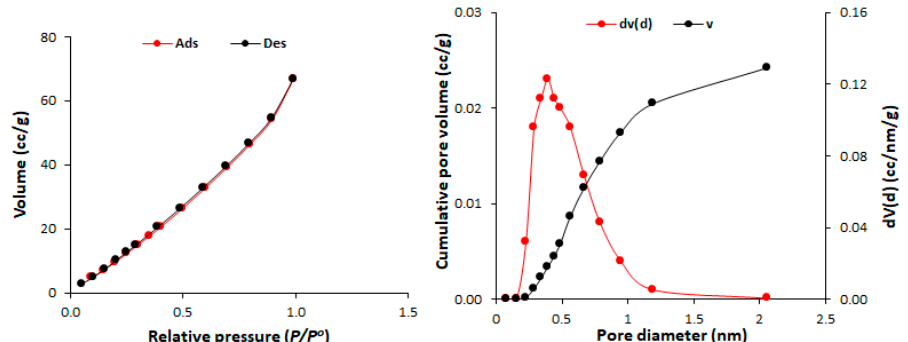
Figure 7. N 2 isotherms and pore size for 3 .